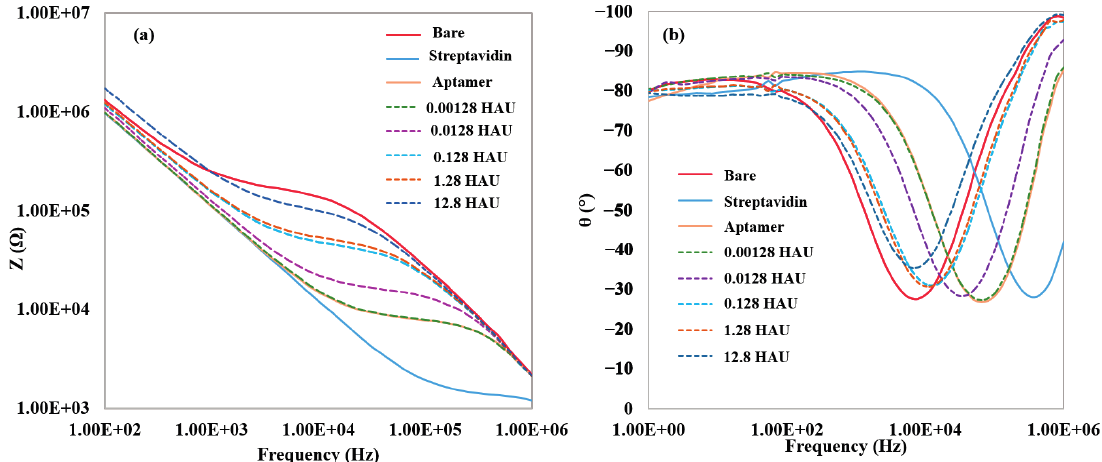
Figure 1. ( a ) Typical impedance magnitude data for the detections of H5N1 AIV; ( b ) Typical phase angle data for the detection of H5N1 AIV. Data labels for dashed lines correspond to serial dilution values (10 1 to 10 5 dilutions) of 128 HAU virus sample (12.8 to 0.00128 HAU). The amplitude of voltage was 100 mV.